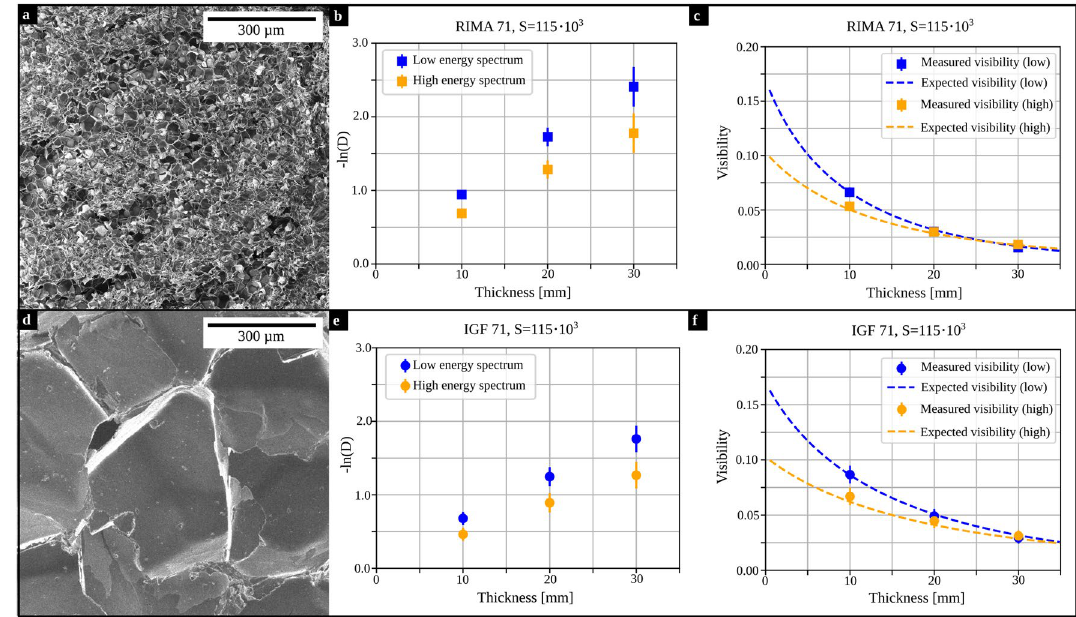
Figure 2. Required data and results from the optimization. ( a , d ) Helium-ion microscopy images of RIMA 71 and IGF 71, respectively. ( b , e ) Measured dark-field signals for increasing thicknesses of the materials. The dark- field values vary for both materials. ( c , f ) Comparison between measured (data points; standard deviation given as error bars) and expected visibility (dashed line) calculated for the optimized parameters a and b and Eq. (6), 3 at S = 115 · 10